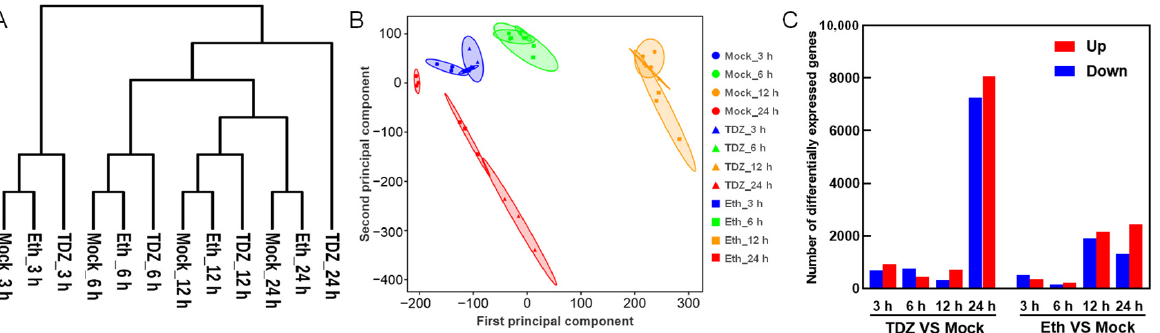
Figure 3. Transcriptome features and relationships among all samples. ( A ) Hierarchical clustering diagram showing the time series distribution of the samples. Cotton plants were treated with 300 mg/L thidiazuron (TDZ) or 0.6 mg/L ethephon (Eth). Mock: water. ( B ) Principal component analysis (PCA) of 36 libraries taken at 4 time points. ( C ) The number of up- and downregulated differentially expressed genes in cotton leaf upon TDZ or Eth treatment.